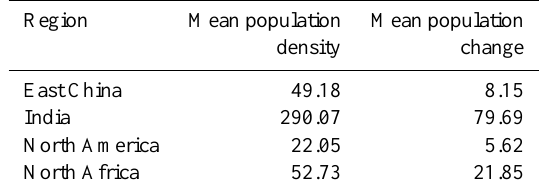
Figure 8. Mean population density (personskm − 2 ) (red) and popu- lation change (personskm − 2 ) (blue) in the four geographical semi- arid regions. Table 2. Mean population density/change (personskm − 2 ) in four geographical semi-arid